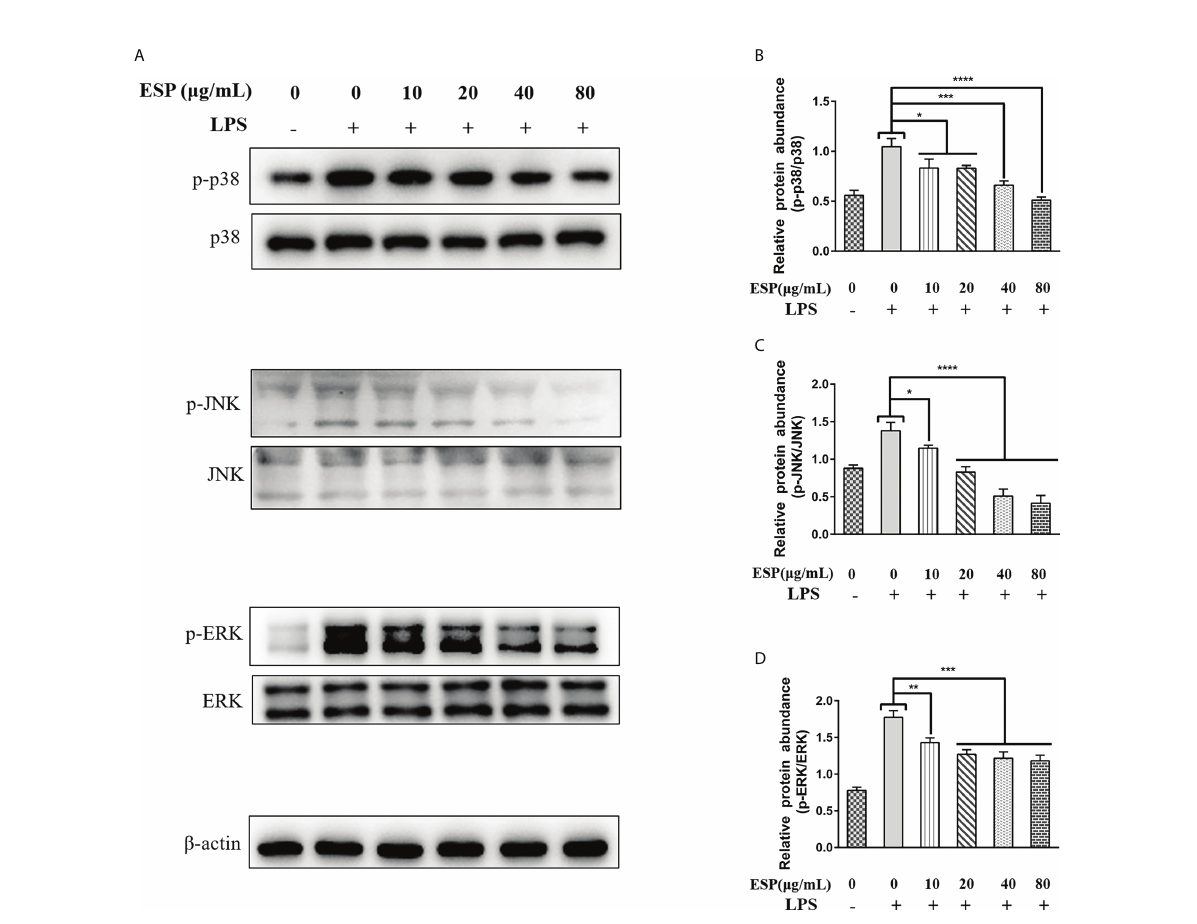
FIGURE 6 HcESPs inhibited the activation of the MAPKs signaling pathway. Cells were stimulated with LPS (1 m g/Ml) to establish an in fl ammation model, followed by incubation with different concentrations (10, 20, 40, 80 m g/mL) of HcESPs or equal volumes of RPMI 1640 medium at 37°C and 5% CO 2 for 24 h. A blank control group was set up (RPMI 1640 instead of LPS and HcESPs). (A) : Detection of protein expression levels of p38, p- p38, JNK, p-JNK, ERK, and p-ERK by Western blot; (B – D) : Statistics of the p-p38, p-JNK, and p-ERK; Data are presented as the mean±SEM from three independent experiments. Asterisks indicate signi fi cant differences at * P <0.05, ** P <0.01, *** P <0.001, and **** P